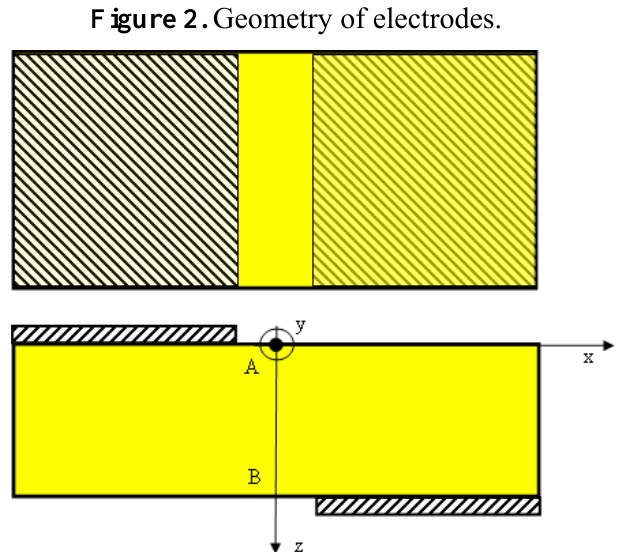
Figure 2. Geometry of